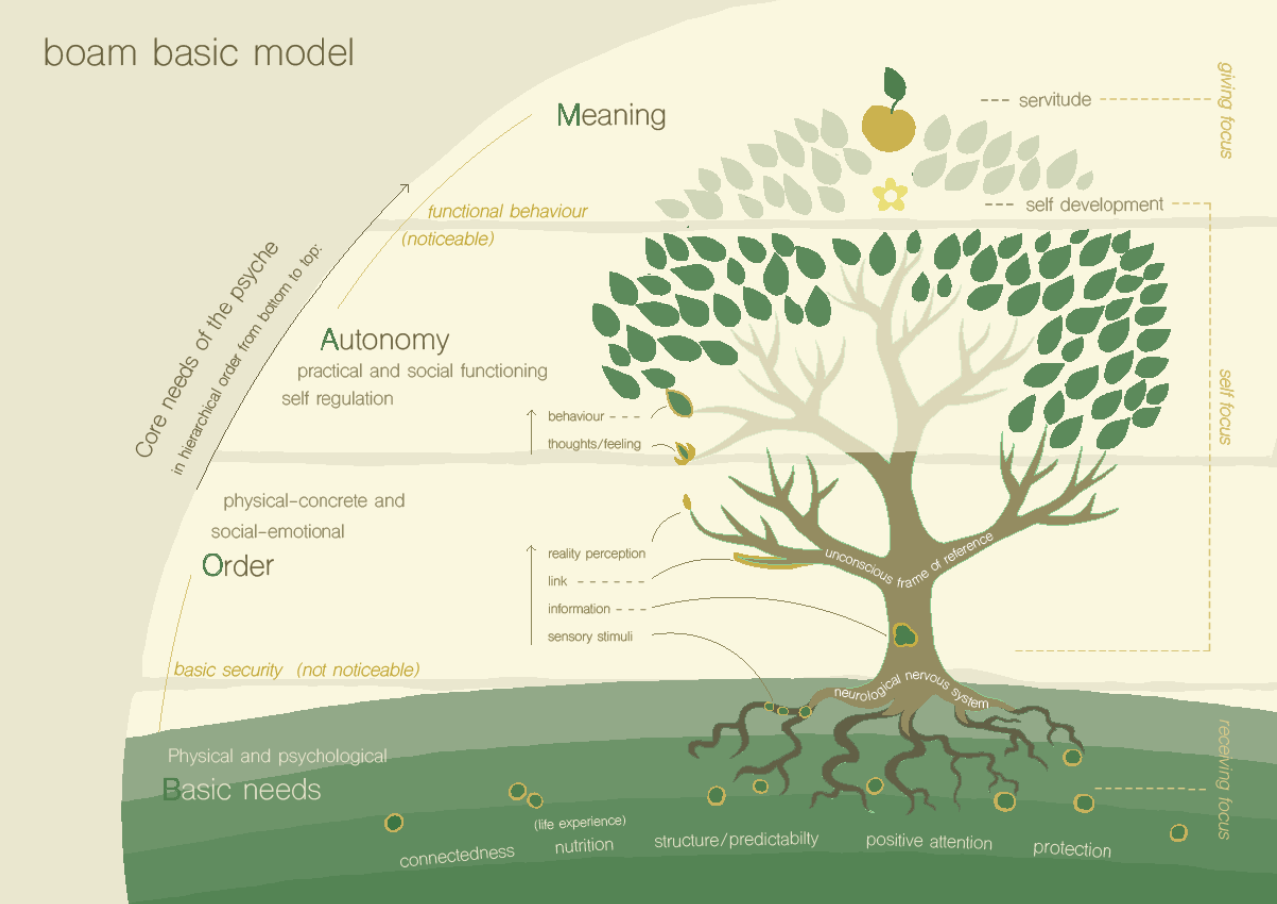
Figure 1. The BOAM basic model depicting psychological functioning (Truijens, in prep.).